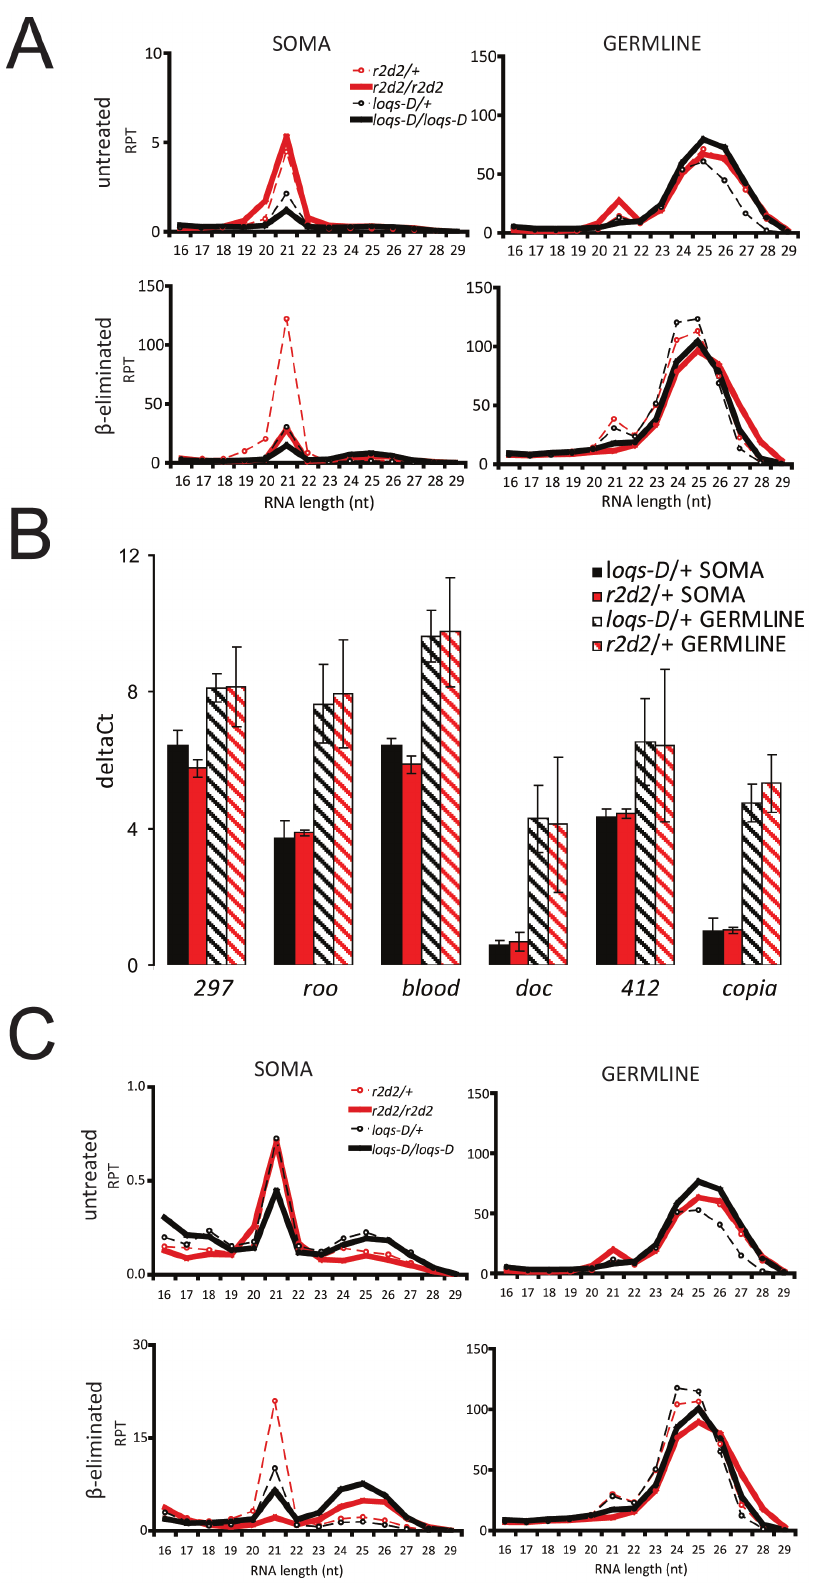
Figure 1. Length distribution of transposon-matching small RNAs identified in this study. A) Reads of each library originating from soma and germline were mapped to the reference containing a transposon sequence collection. Transposon matching small RNAs were analyzed for their size distribution and normalized to total genome matching reads. The normalized counts were expressed as reads per thousand (RPT). B) The steady